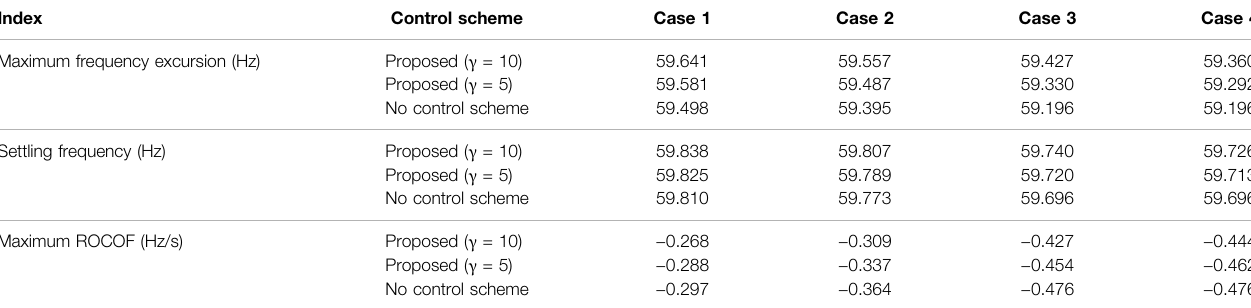
TABLE 1 | Summary of all